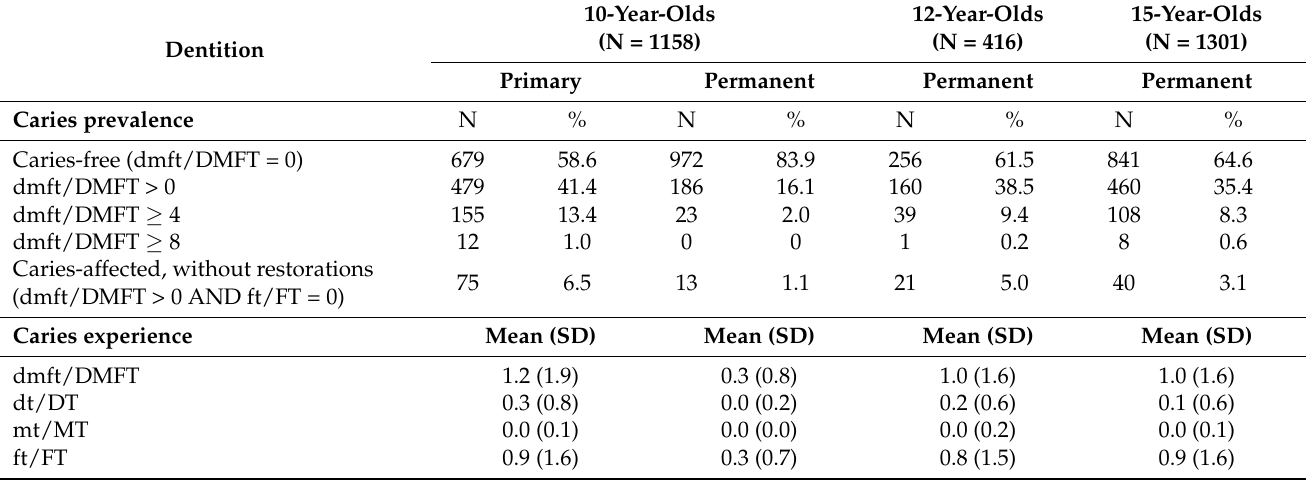
Table 2. Descriptive characterization of the caries experience and polarization according to the dmft/DMFT index, its com- ponents, the Significant Caries Index (SiC), and Specific Affected Caries Index (SaC) in relation to different threshold values.